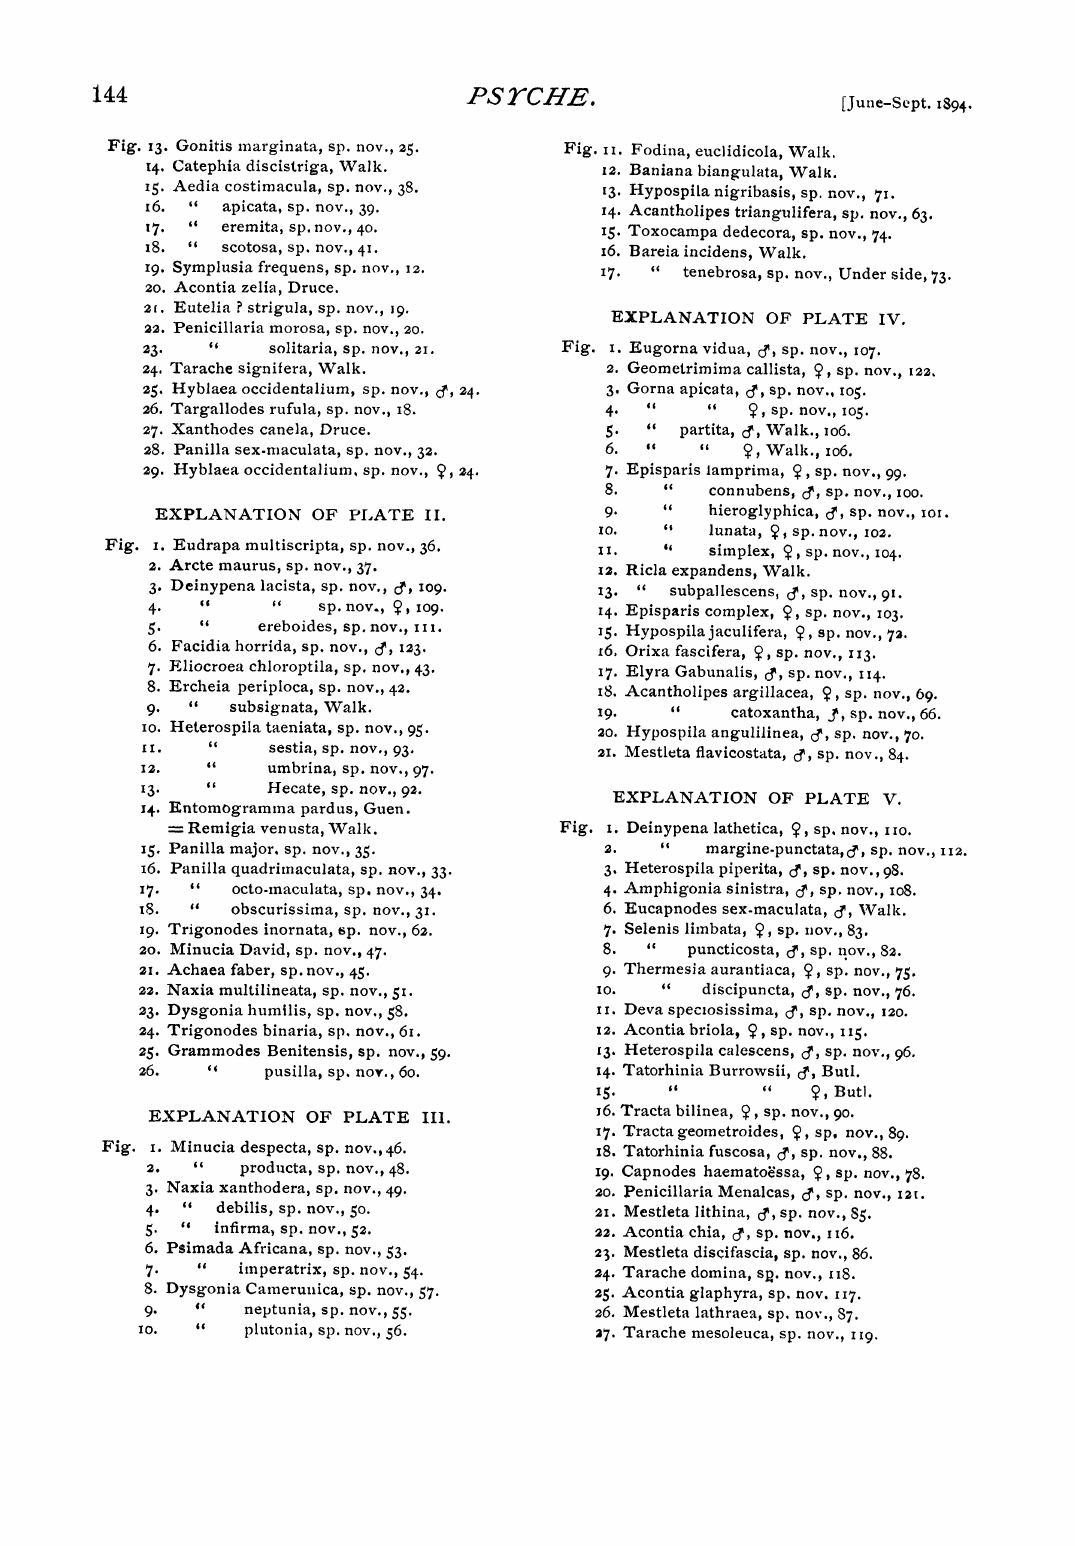
PS YCI-IE. Fig. Fodina, euclidicola, Walk. 12. Baniana biangulata, Walk. I7. EXPLANATION OF PLAT:E IV. , , Fig. I. Eugorna vidua, sp. nov., io 7. , sp. nov., 22. 2. Geometrimima callista, sp. nov., io 5. 3. Gorna apicata, , , 4. 9, sp. nov., io 5. Walk., o6. , 5. partita, o , 6. Walk., lO6. 7. Episparis lamprima, sp. nov., 99. 24. 8. connubens, ct, sp. nov., Ioo. , , 9. hieroglyphica, @, sp. nov., xo. sp. nov., Io2. Io. lunata, sp. nov., io 4. II, sitnplex, , 12. Ricla expandens, Walk. 13. Io 9. 9. 2I. Mestleta flavicostata, d’, sp. nov., 84. EXPLANATION OF PLATE V. , Fig. I. Deinypena lathetica, ?, sp. nov., txo. , sp. nov., i12. 2. margine-punctatad , sp. nov., 98. 3. Heterospila piperita, o , sp. nov., Io8. , 4. Amphigonia sinistra, d 6. Eucapnodes sex-maculata, d XValk. , , sp. nov., 83. 7. Selenis limbata, 8. puncticosta, d sp. n.ov., 82. , sp. nov., 7. 9. Thermesia aurantiaca, , xo. discipuncta, d sp. nov., 76. , Deva specosissima, 0 sp. nov., 12o. sp. nov., 5. 12. Acontia briola , , 3. Heterospila calcscens, o, sp. nov., 96. Bud. 4. Tatorhinia Burrowsii, o I5.